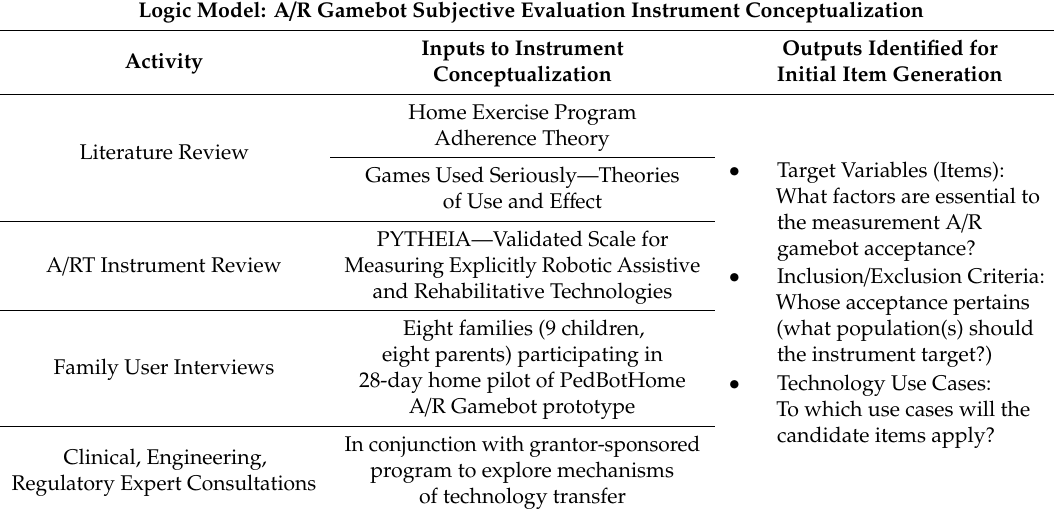
Figure 1. Conceptualization phase (highlighted) of A/R gamebot subjective evaluation in the context of overall instrument development (European Statistical System Model [33]). Table 1. Conceptualization of an instrument for the subjective evaluation of A/R gamebot technology.